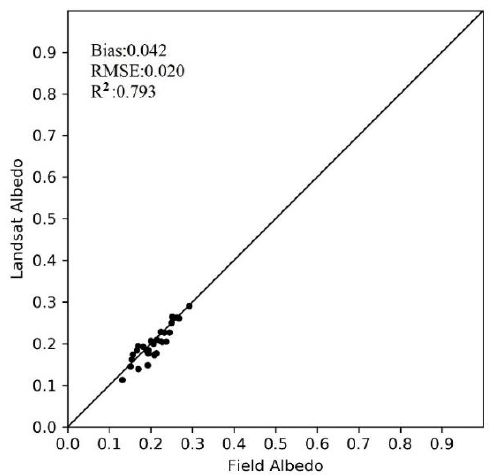
Figure 5. Comparison of Landsat-8 estimated albedo with ground measurements. The clear and cloudless GF-1 WFV and Landsat-8 data with adjacent imaging times were selected, and black-sky and white-sky albedos were estimated and compared. The GF-1 WFV was imaged on 23 February 2015 (DOY = 54), and Landsat-8 was imaged on 24 February 2015 (DOY = 55). The comparison of albedo estimation results is shown